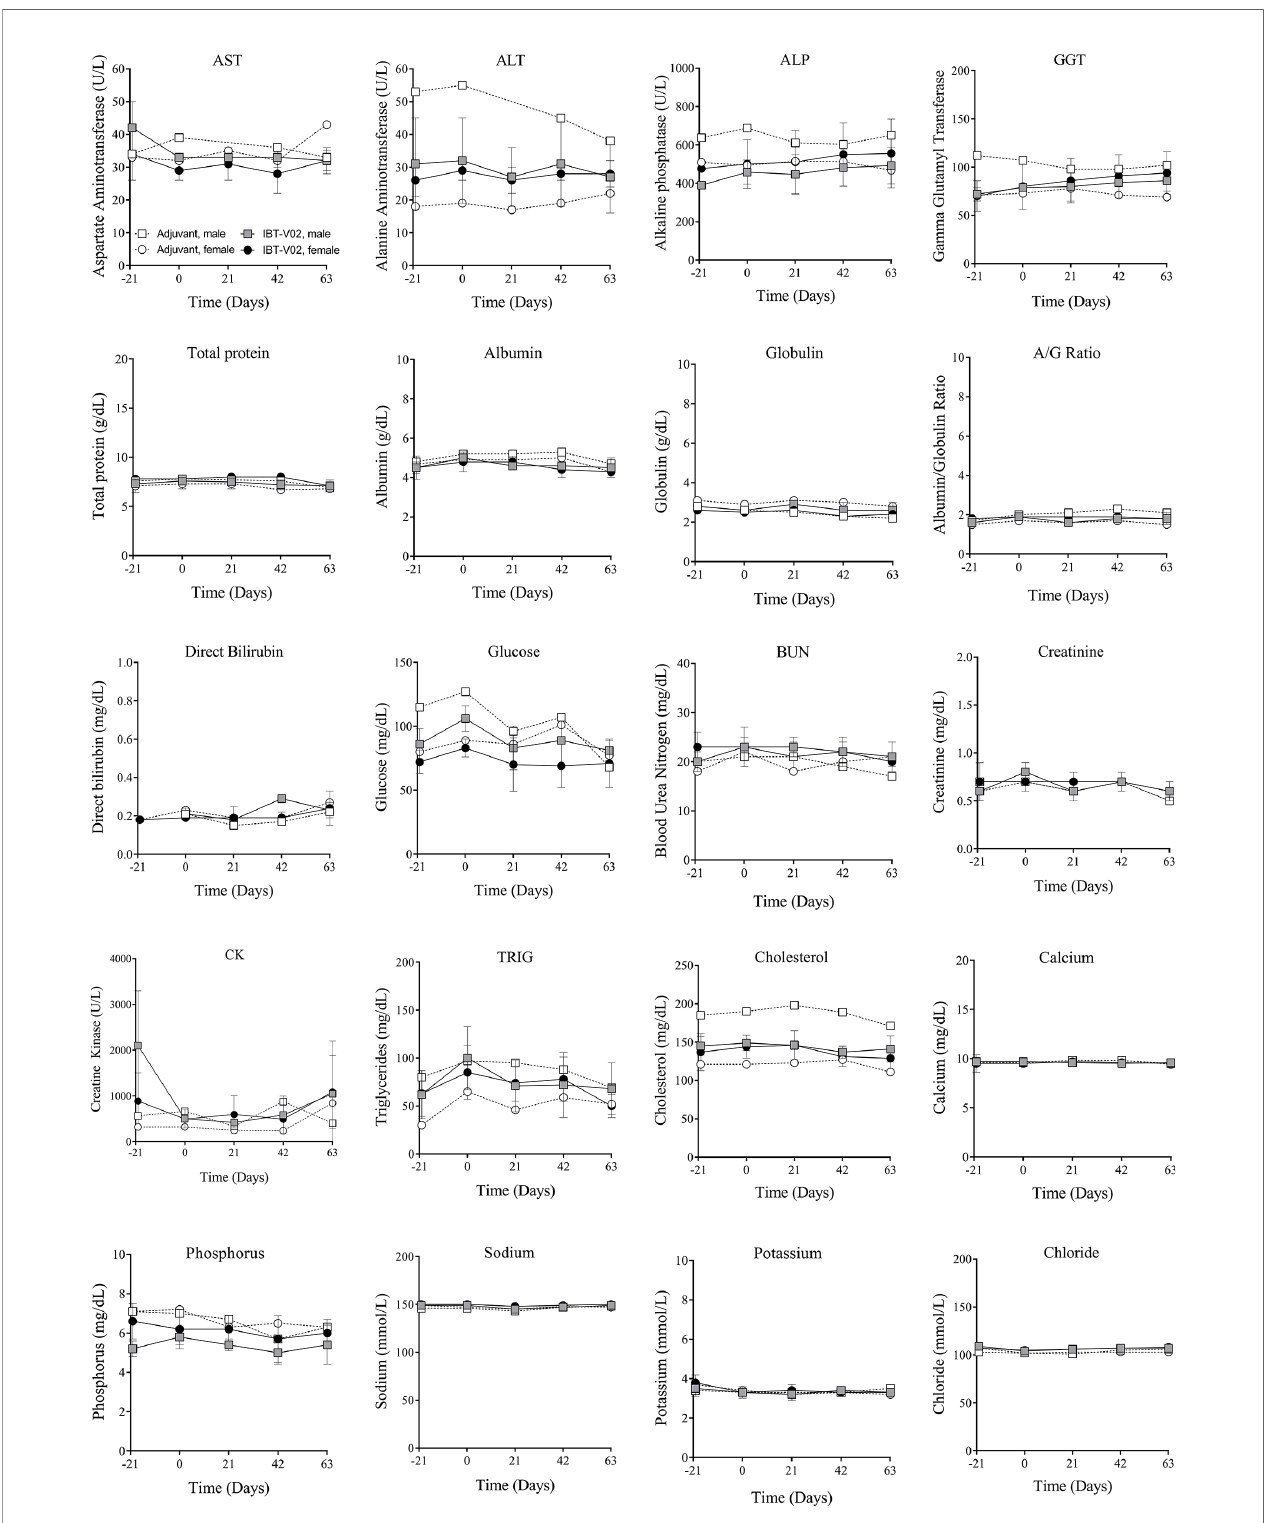
FIGURE 3 | Serum chemistry. Chemistry values of non-human primates (NHPs) measured in serum samples collected at indicated timepoints before each vaccination on days 0 (D0), 21 (D21), and 42 (D42) and on day 63 (D63). Data was analyzed with GraphPad PRISM